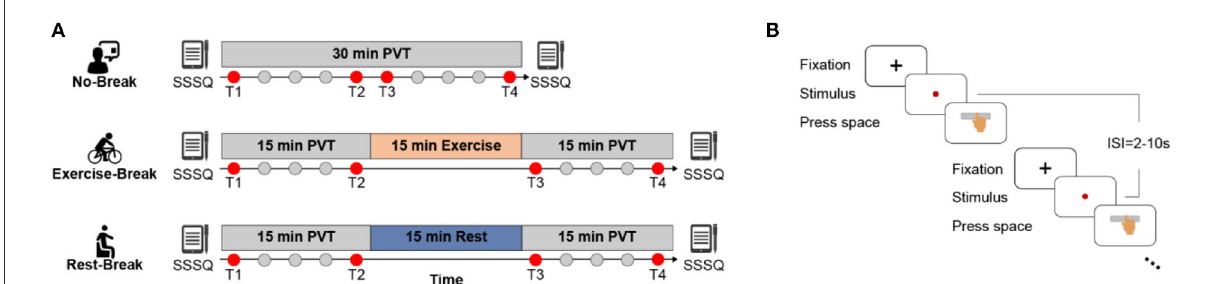
FIGURE1 Schematic illustration of the experimental protocol. (A) No-Break session includes a 30-min continuous PVT task, while Exercise-Break and Rest-Break session are intervened by a 15min mid-task exercise and mid-task rest, respectively. Of note, T1 and T4 that correspond to the first and last 3min of each session; and T2 and T3 that represent the pre-break and post-break 3min of each session were defined to investigate the immediate effect (T2 vs. T3) and general effect (T1 vs. T4) for post-break intervention. (B) The detailed paradigm of PVT task. Subjects were required to press the space bar as quickly as possible after monitoring the stimulus (red dot), with 2–10s inter-stimulus-intervals